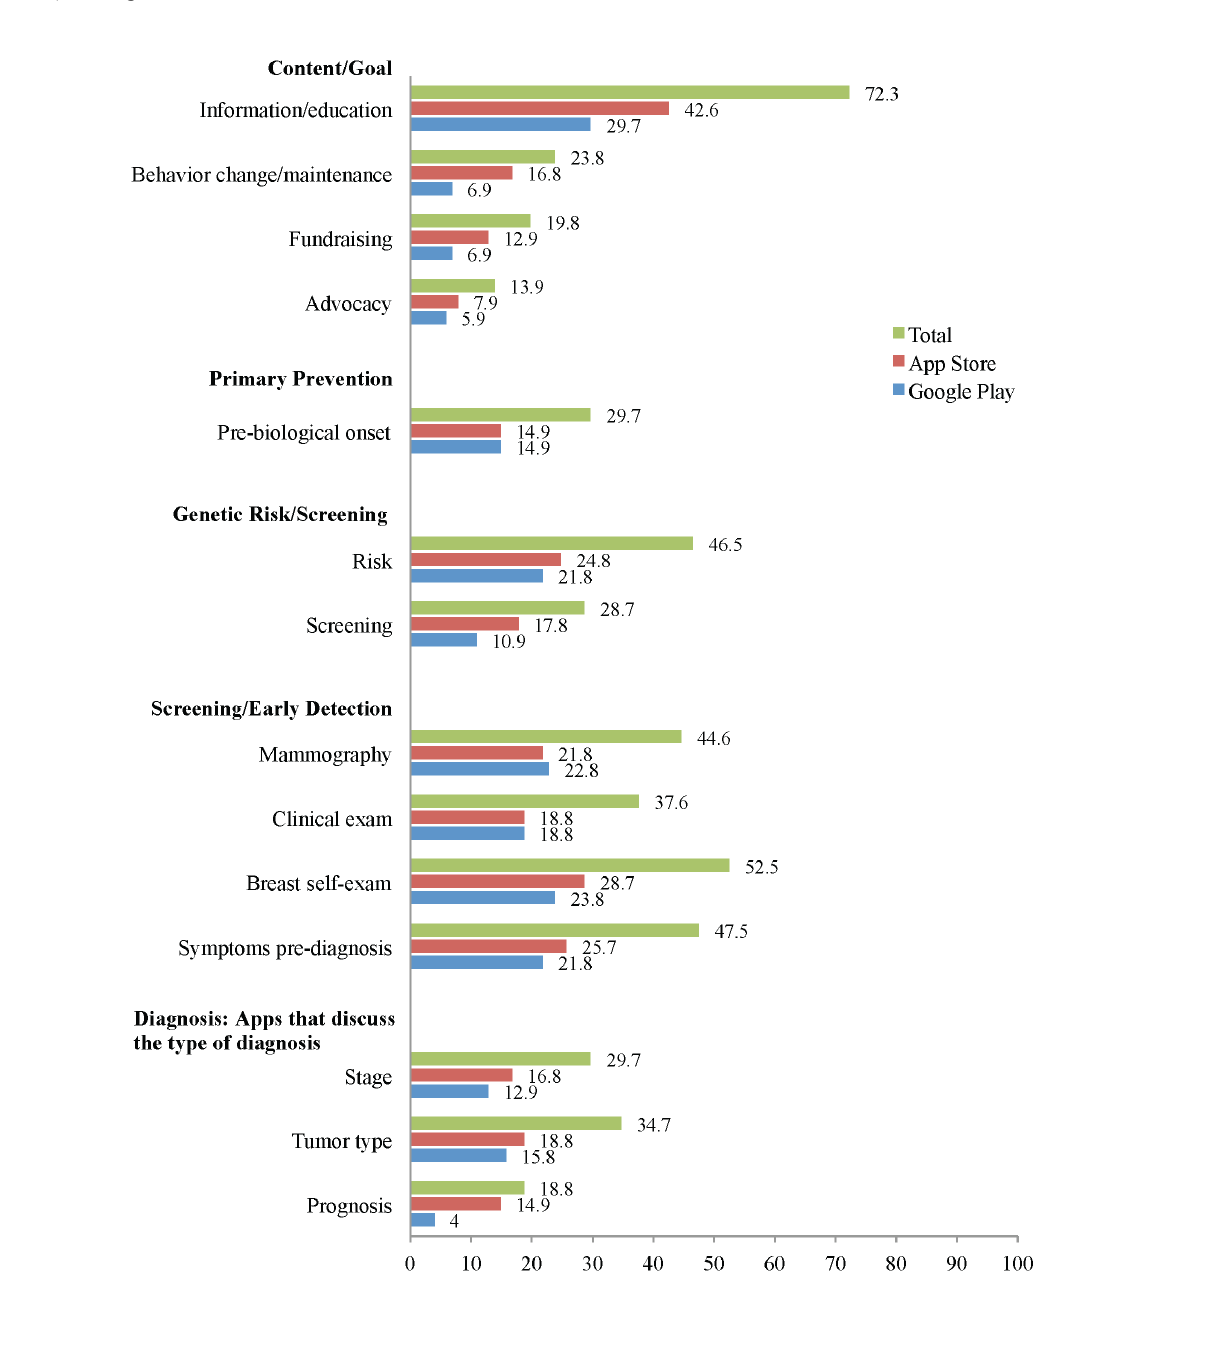
Figure 2. App characteristic percentages on App Store and Google Play: content/goal, primary prevention genetic risk/screening, screening/early detection, and diagnosis